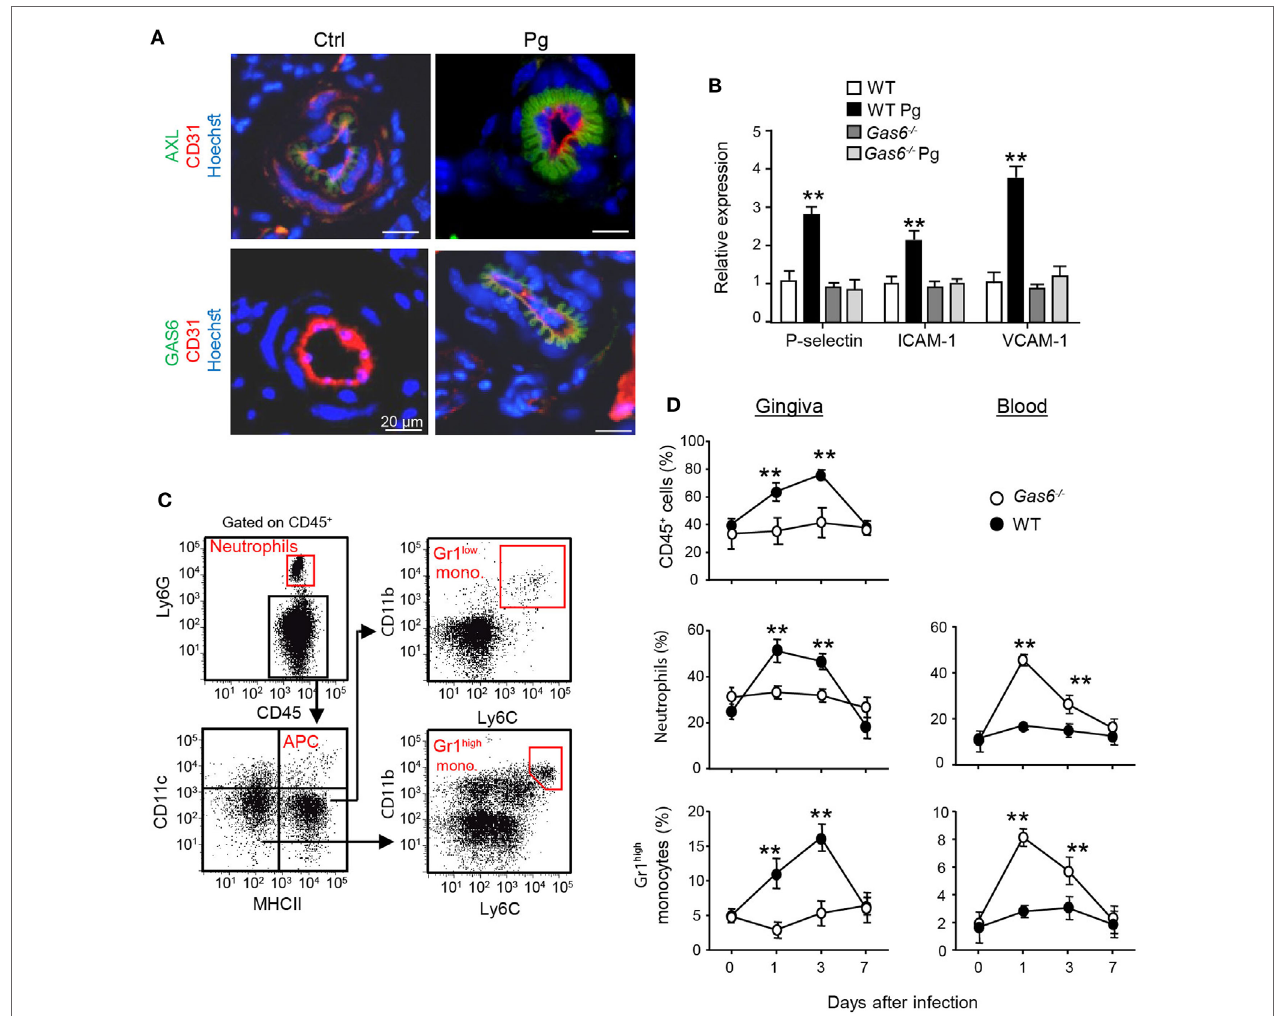
FigUre 5 | Infiltration of innate leukocytes to the gingiva is blocked in infected Gas6 − / − mice. (a) Immunofluorescence staining of AXL or growth arrest-specific 6 (GAS6) (green), CD31 (red), and hoechst (blue) in gingival lamina propria cross sections of Pg -infected and naive WT and Gas6 − / − mice. Representative images of at least three independent experiments. Scale bars represent 20 µm. (B) Expression of P-selectin, ICAM-1, and VCAM-1 in the gingiva of WT and Gas6 − / − mice 24 h following infection with Pg. Relative mRNA expression levels are presented using RT- q PCR analysis representing the mean of five mice per group ± SEM. Representative data of one out of two independent experiments is shown. (c,D) Quantification of inflammatory cells in the blood and gingiva following a single infection of WT and Gas6 − / − mice with Pg. (c) Gating strategy to identify neutrophils, APCs, Ly6C low , and Ly6C high monocytes in the blood using flow cytometry analysis. (D) Time course analysis of the frequencies of CD45 + cells, neutrophils, and Ly6C high monocytes in the blood versus gingiva in WT and Gas6 − / − mice, representing the mean of five mice per group ± SEM. Representative data of one out of two independent experiments is